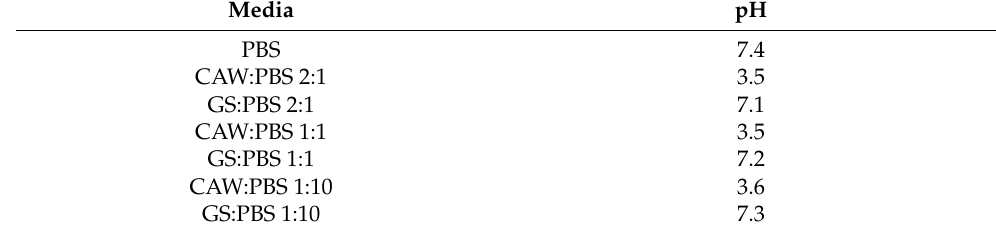
Table 2. The pH values for PBS and mixtures of CAW:PBS and GS:PBS at different ratios ( w / w ).